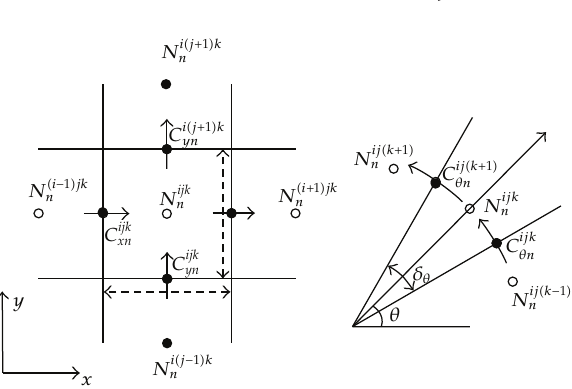
Figure 1: Arrangement of variables in